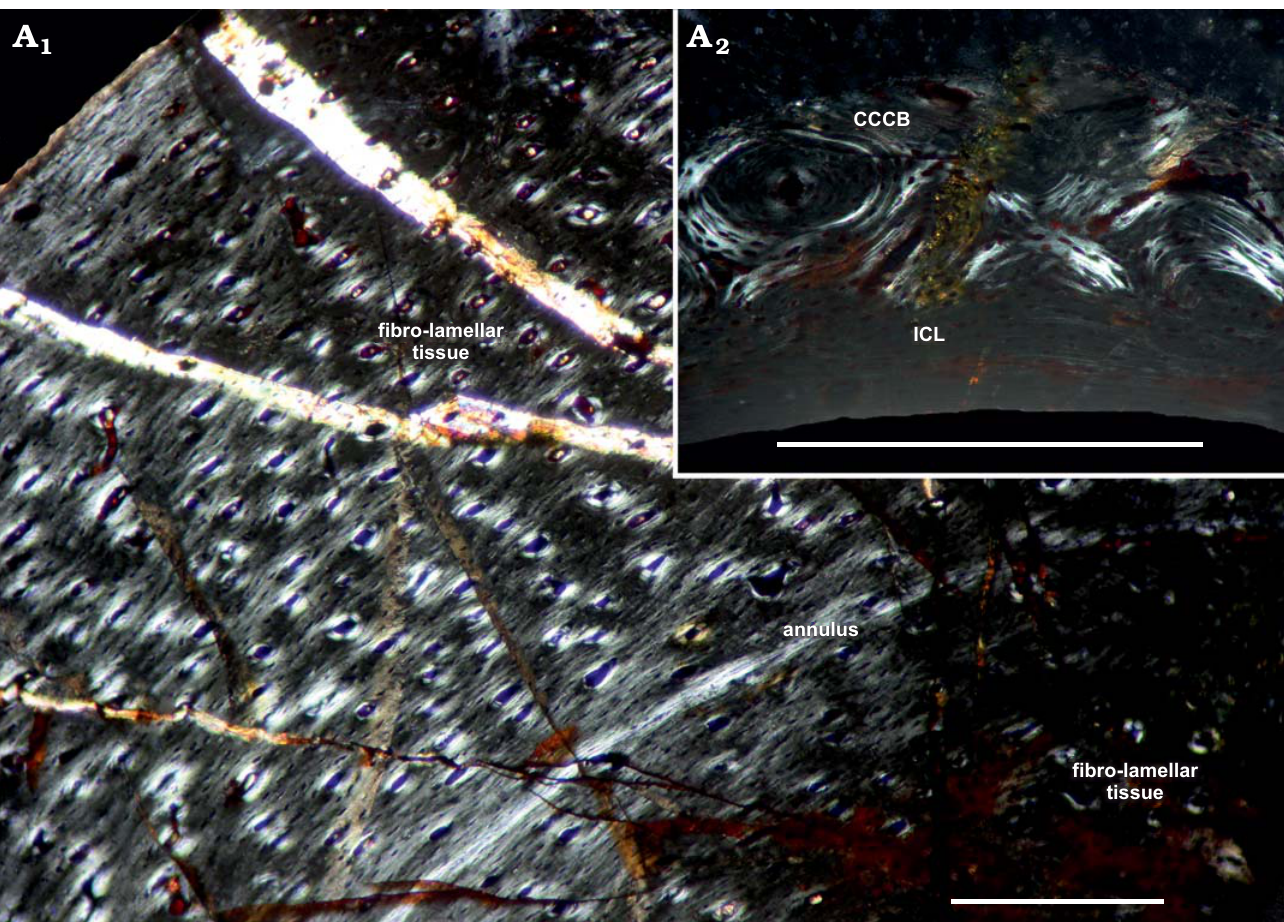
Fig. 3. Femur of archosauromorph Lagerpeton chanarensis Romer, 1971 (PVL-4625, in polarized light) from La Rioja province, NW Argentina; Chañares Formation, Carnian (Late Triassic). Section showing the inner circumferential layer and the cortex (A 1 ), detail of the compact coarse cancellous bone (A 2 ). Abbreviations: CCCB, Compact Coarse Cancellous Bone; ICL, Inner Circumferential Layer. Scale bars 300 μ